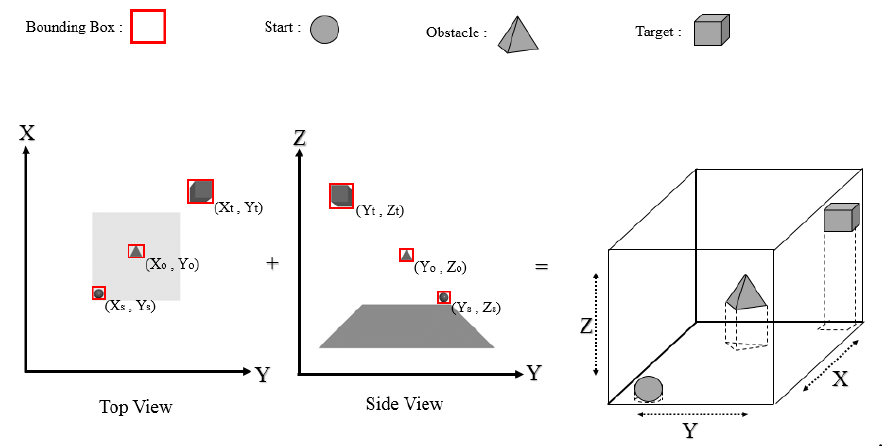
Figure 2. YOLO object detection in two views.